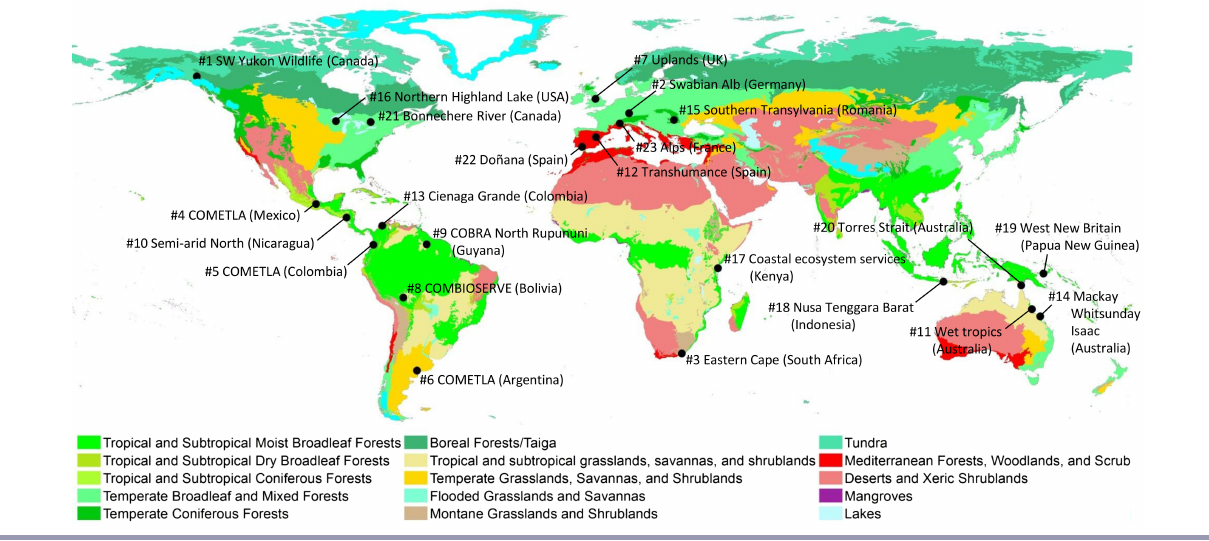
Fig. 1 . World map of biomes (Olson et al. 2001) indicating the location of the 23 case studies